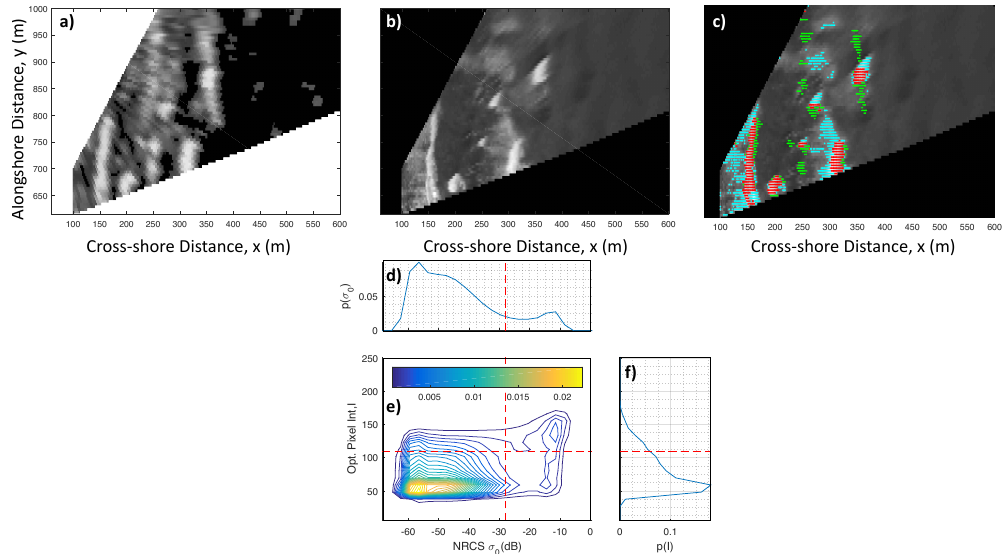
Figure 1. Example of the joint discrimination algorithm. ( a ) Snapshot of video image; ( b ) snapshot of marine radar image; ( c ) snapshot of video image overlain with red, green and cyan dots corresponding to detected active breaking, foam and steepening waves, respectively. ( d ) pdf of the marine radar data; ( e ) jpdf ; and ( f ) pdf of video data. Red lines show the thresholds used in this set. In ( a – c ) waves propagate from the right to the